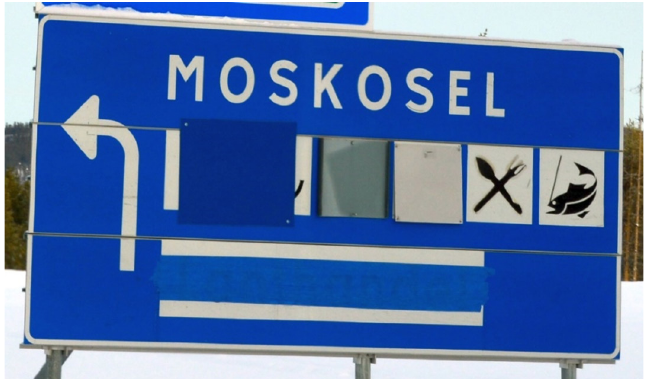
Fig. 3. Road-side sign to Moskosel, January 2018 (by